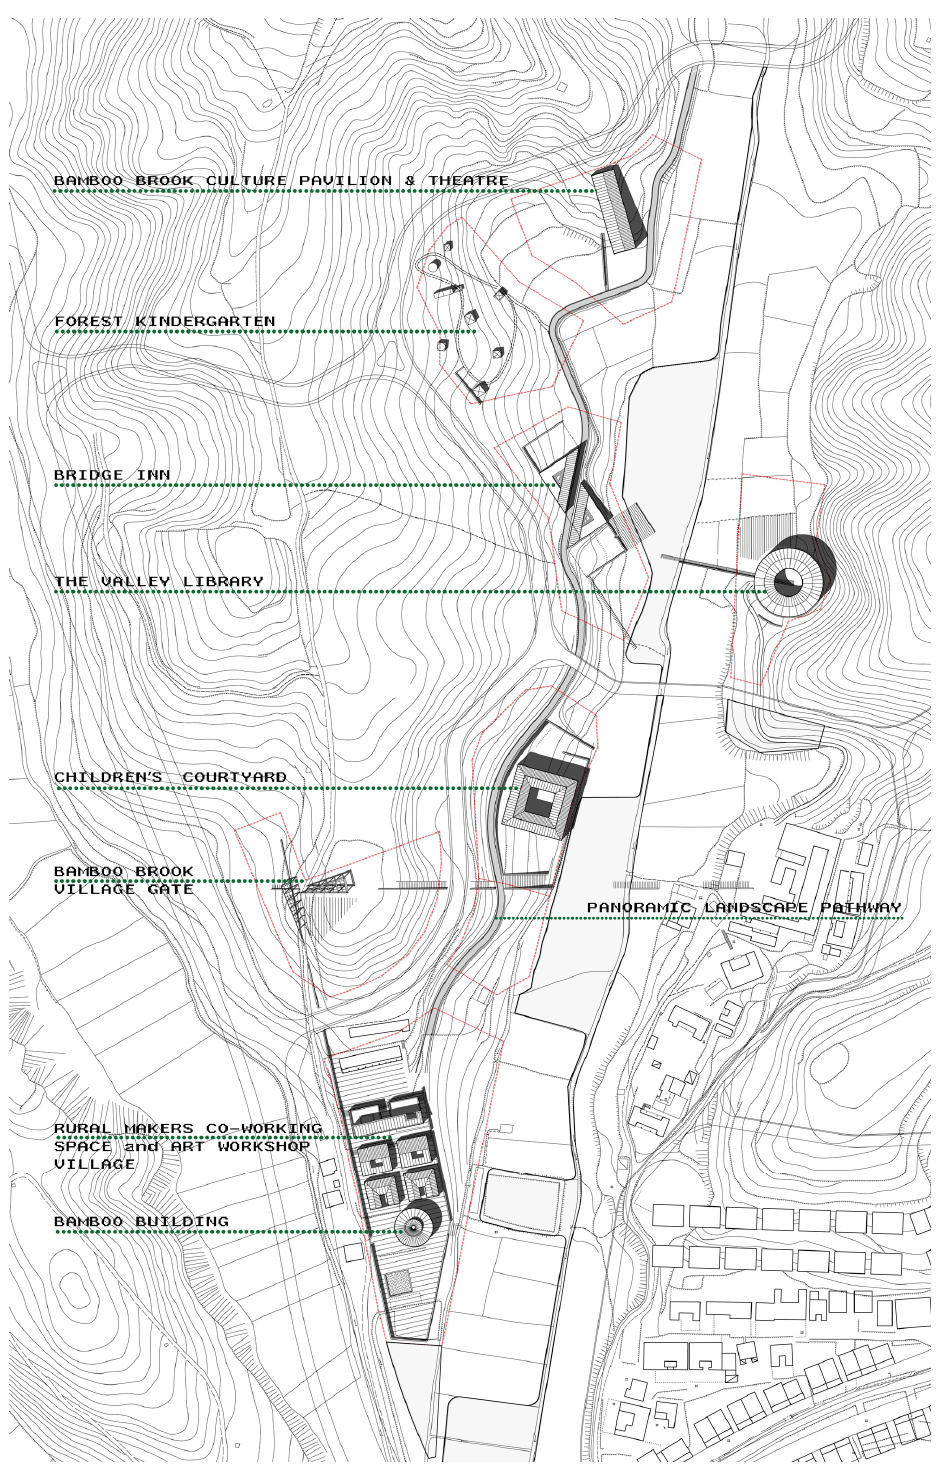
Figure 3. Master plan of the village. Notably, the new functions create a landscape visual interaction between nature and